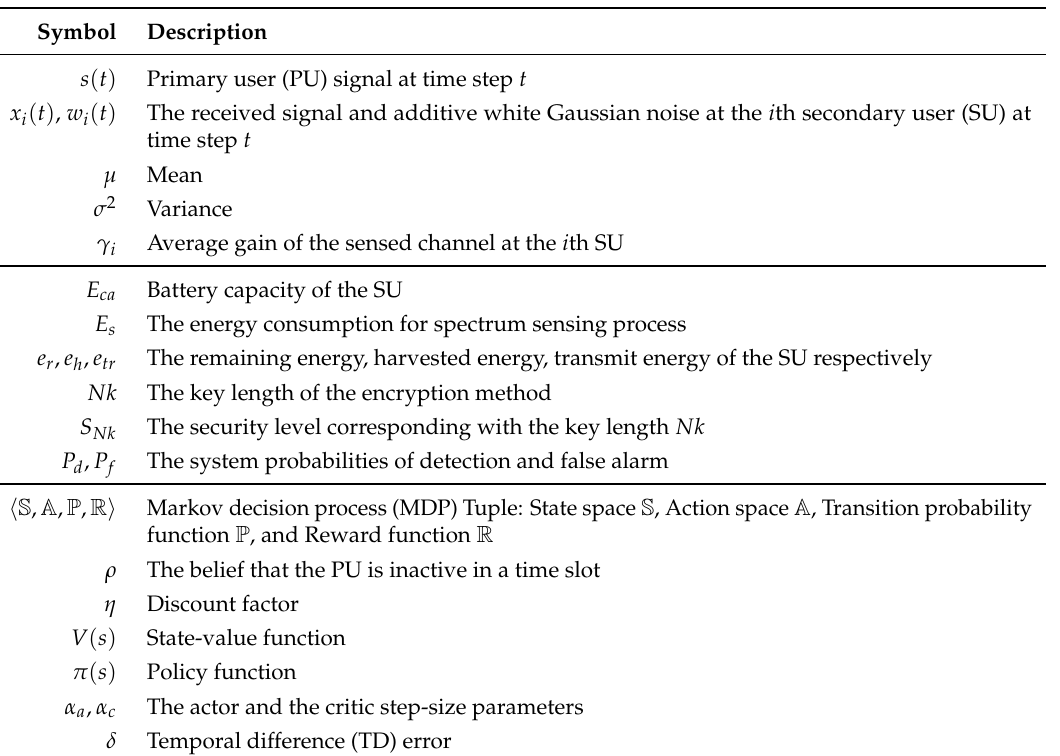
Table 1. The list of the most used notations.